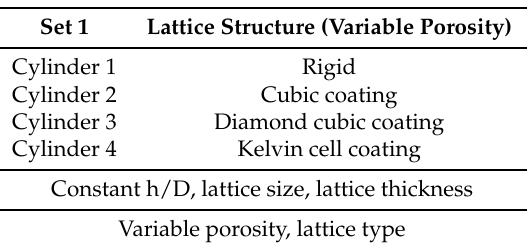
Table 1. Cylinders for experiment set 1.